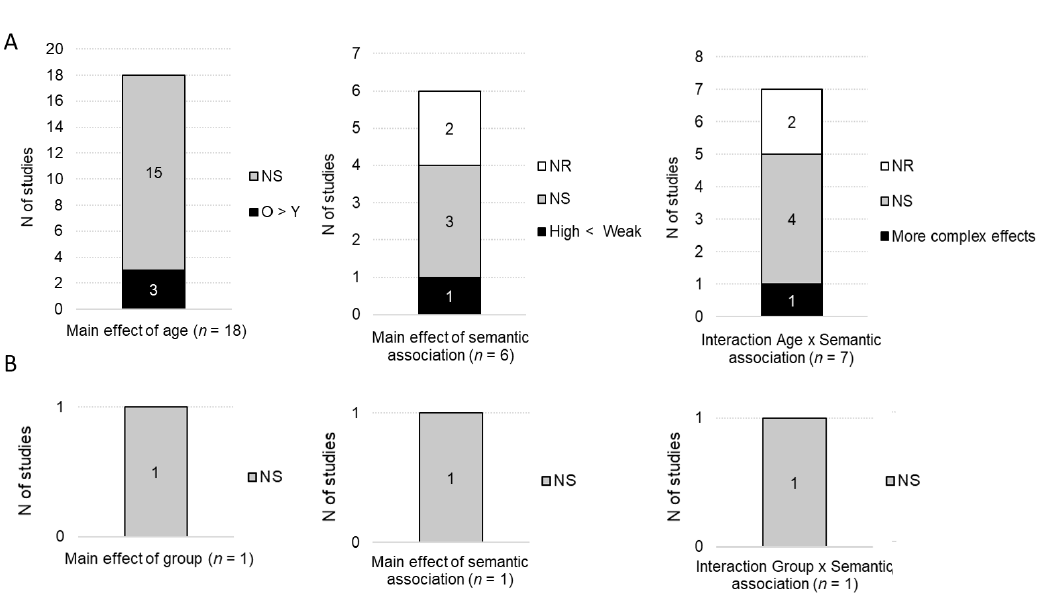
Figure 7. Qualitative results for the N400 peak latency: main effects of age/group, semantic association and the interaction group x semantic association. ( A ) Studies including older and younger groups of participants. ( B ) Studies including AD participants and control groups. N of studies: Number of studies; O: Older; Y: Younger; NS: No significant effect; NR: Statistical significance not reported.